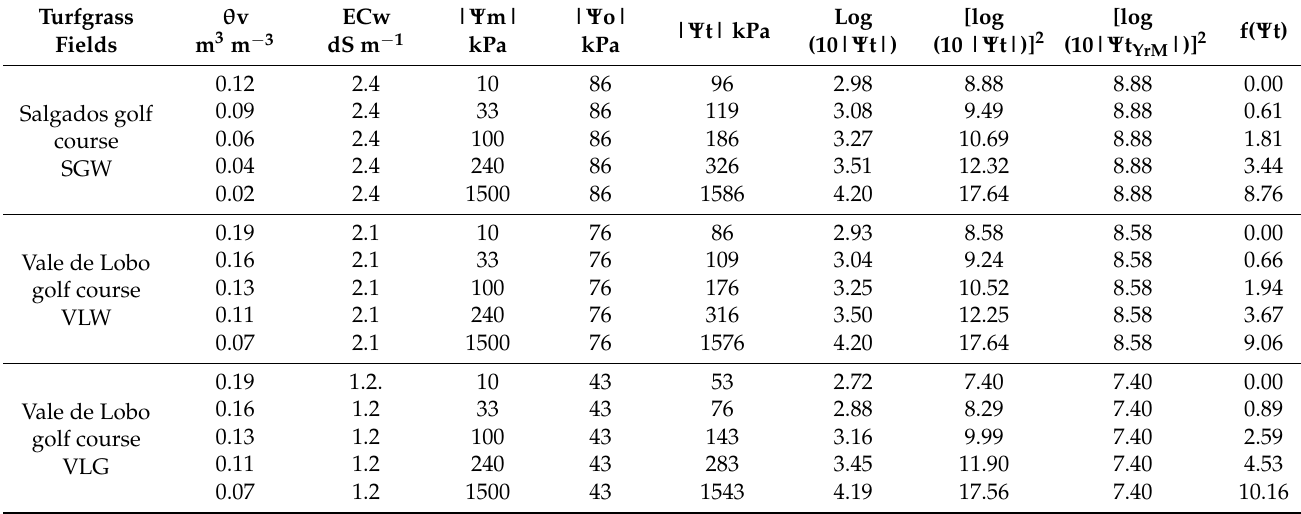
Table 4. Turfgrass fields—function soil total water potential f( Ψ t) and data needed to its calculation, according to the above